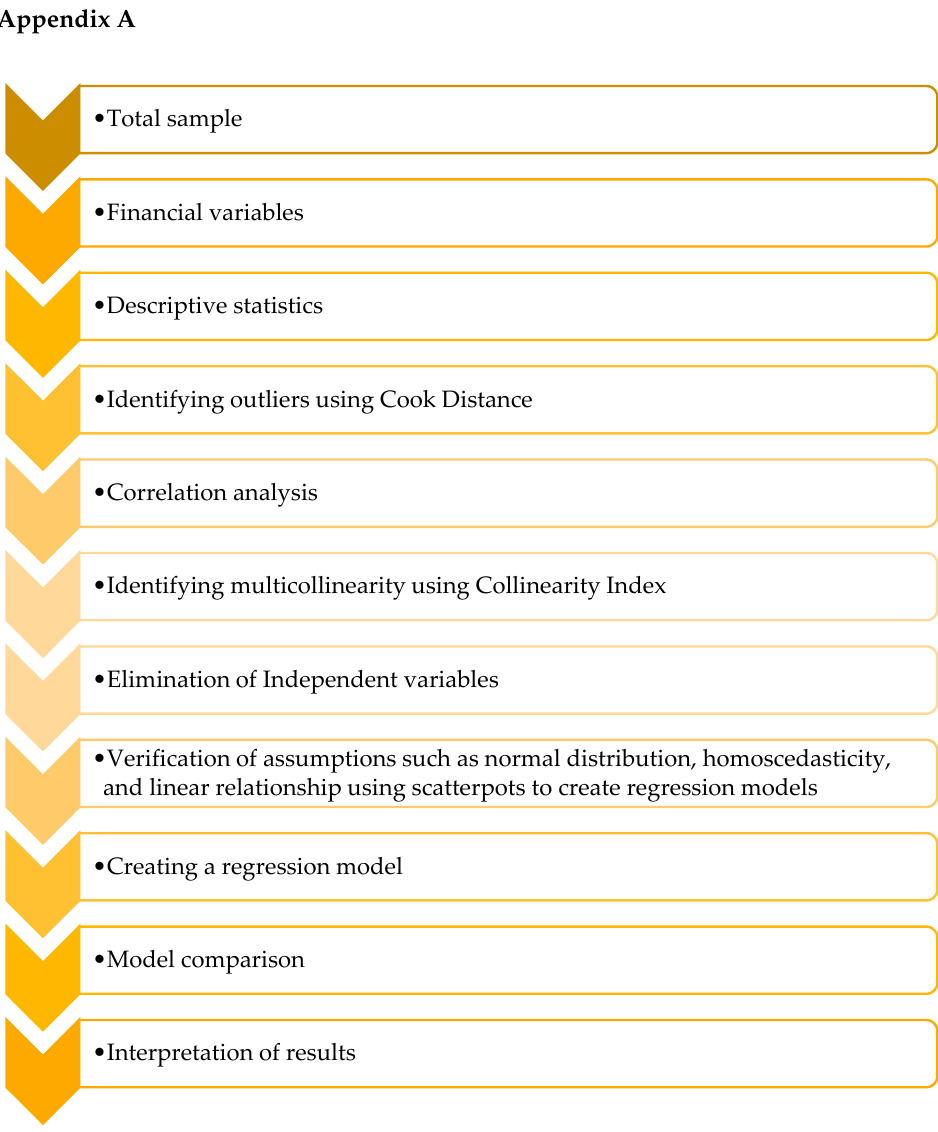
Figure A1. Methodology process.